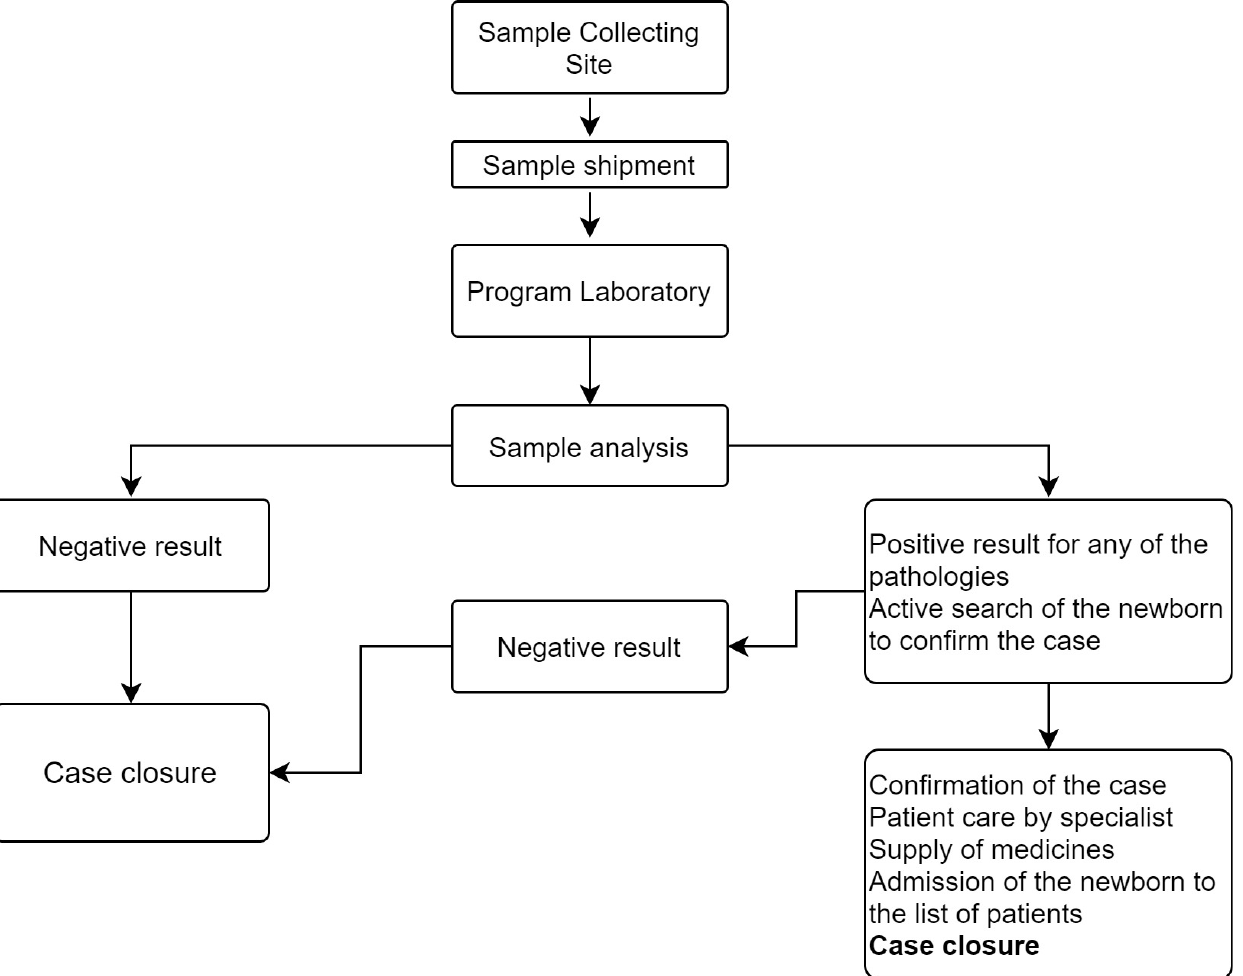
Figure 2. NBS Program